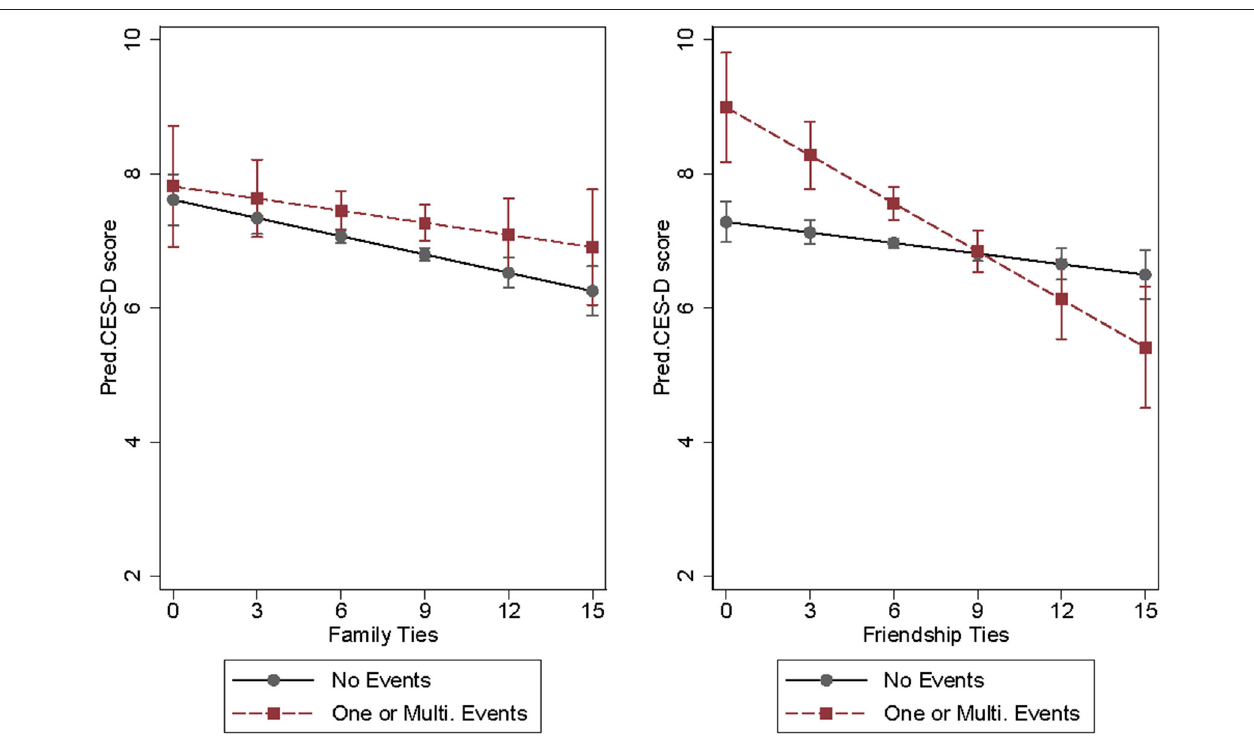
FIGURE 2 | Predicted depressive symptoms by family ties, friendship ties, and negative life events, CLASS 2016–2016, N =